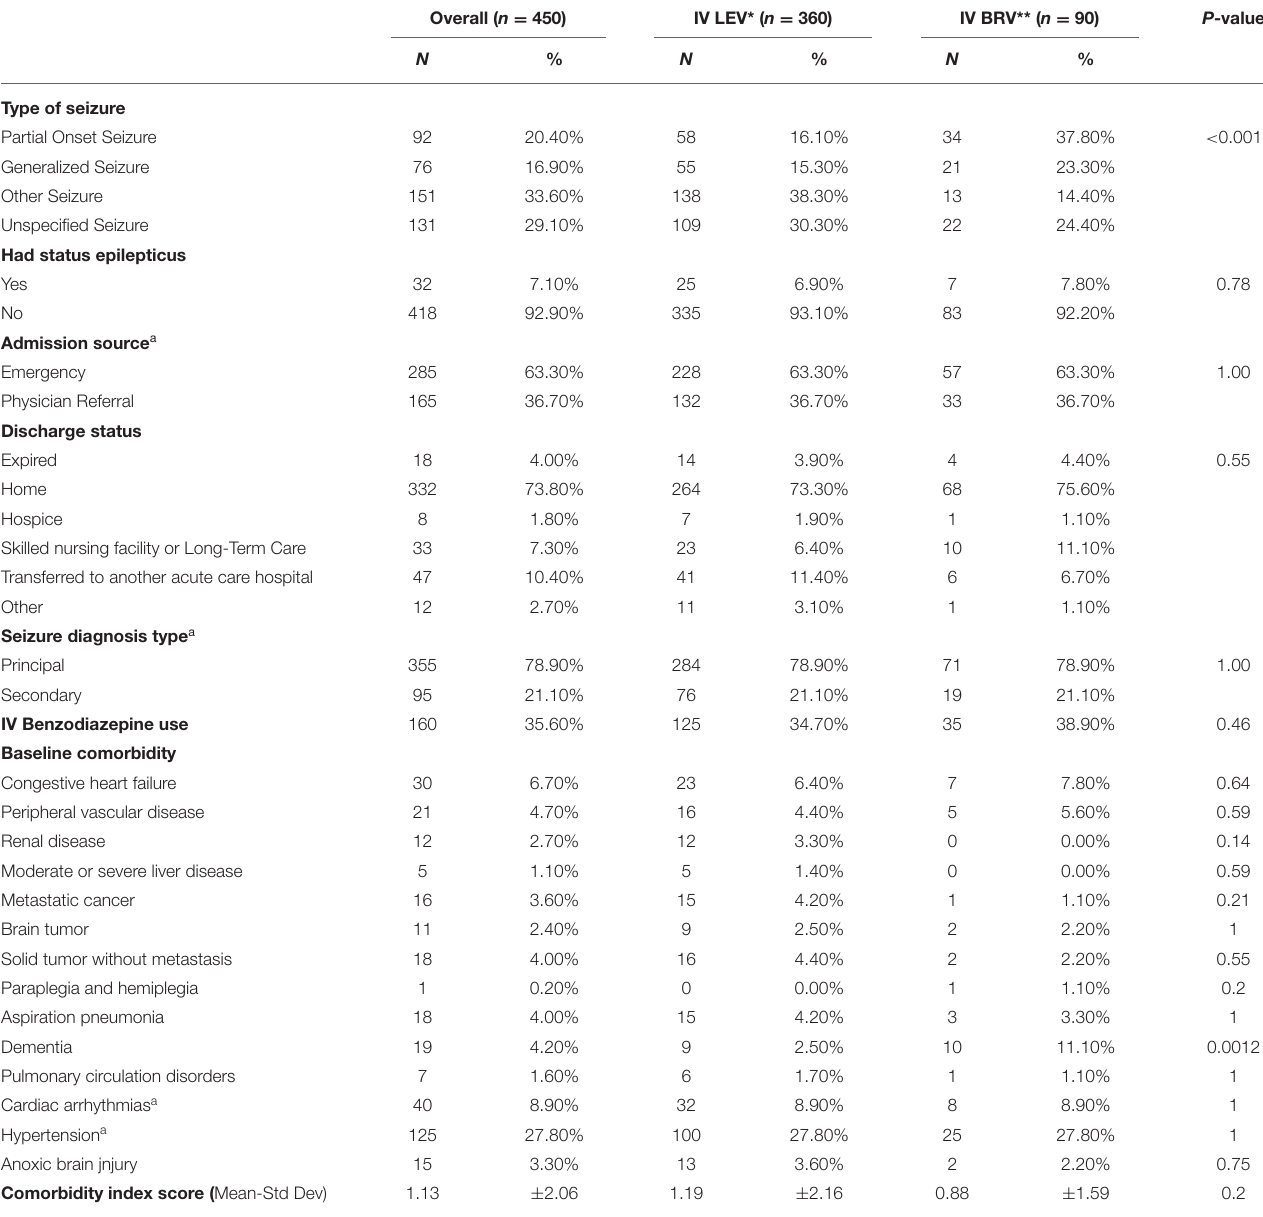
TABLE 2 | Patient clinical characteristics by treatment